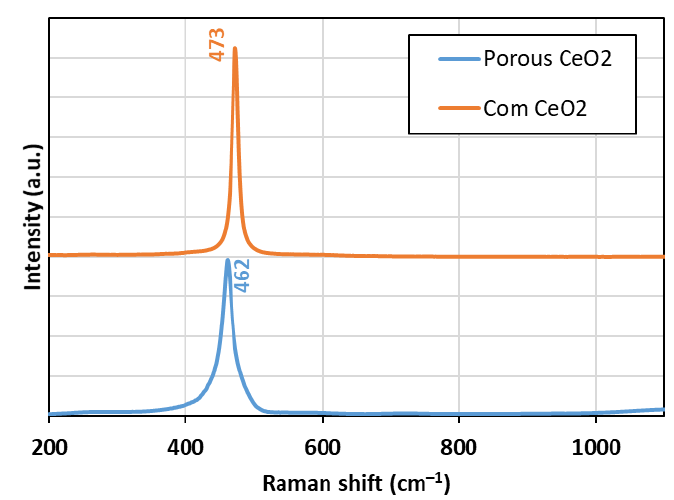
Figure 3. Raman spectrum for porous ceria compared to that of commercial ceria.